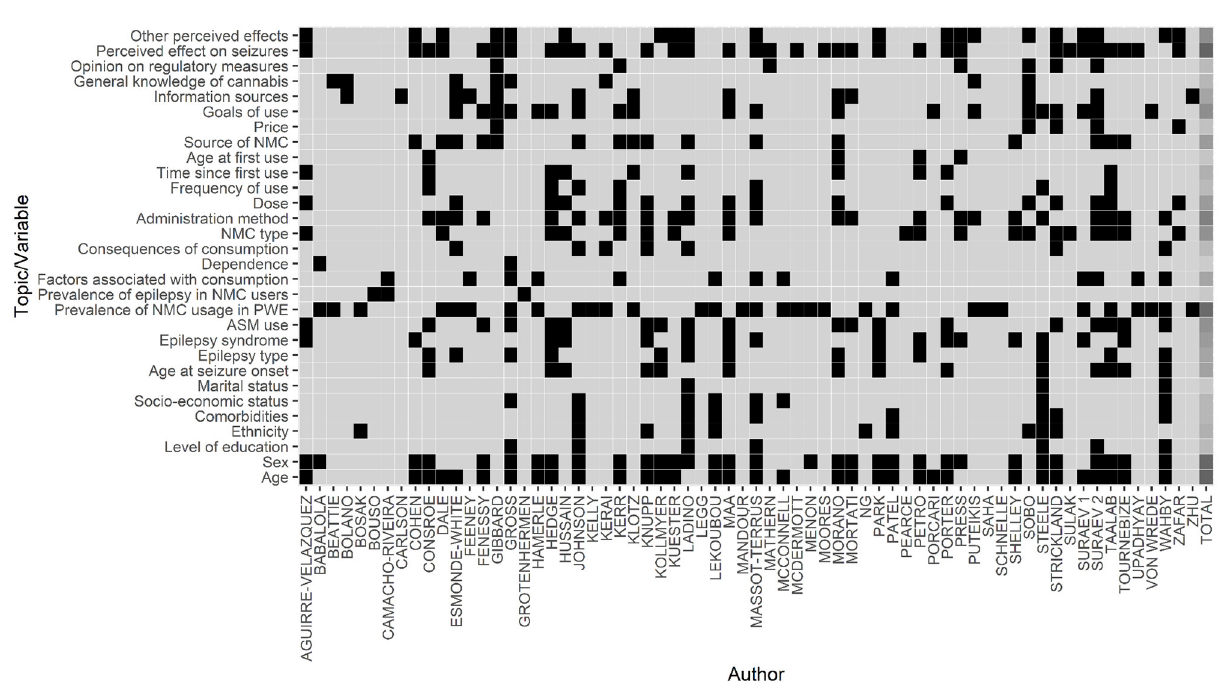
FIGURE2 Heatmap of topics discussed in each included study. This figure consists of a heatmap summarizing which topics were discussed in each included study. The x-axis represents the studies that were included in this scoping review, as identified with the first author. The y-axis represents all the topics that we searched for in each study (see Section 2.4. Data extraction for more information). A black square at the junction between a study (x-axis) and a topic (y-axis) indicates that that topic was discussed in that study. A light gray square at that same junction would indicate that that topic was not discussed in that study. The last column represents the sum of the times each topic was discussed by all authors. In this last column, a square takes on a darker shade of gray as the topic is more “popular” (i.e., it was discussed in more publications). For instance, the perceived effect of seizures was a topic that was discussed in many studies, whereas the age at first use of cannabis was rarely discussed. ASM, anti-seizure medication; NMC, non-medical cannabis; PWE, people with